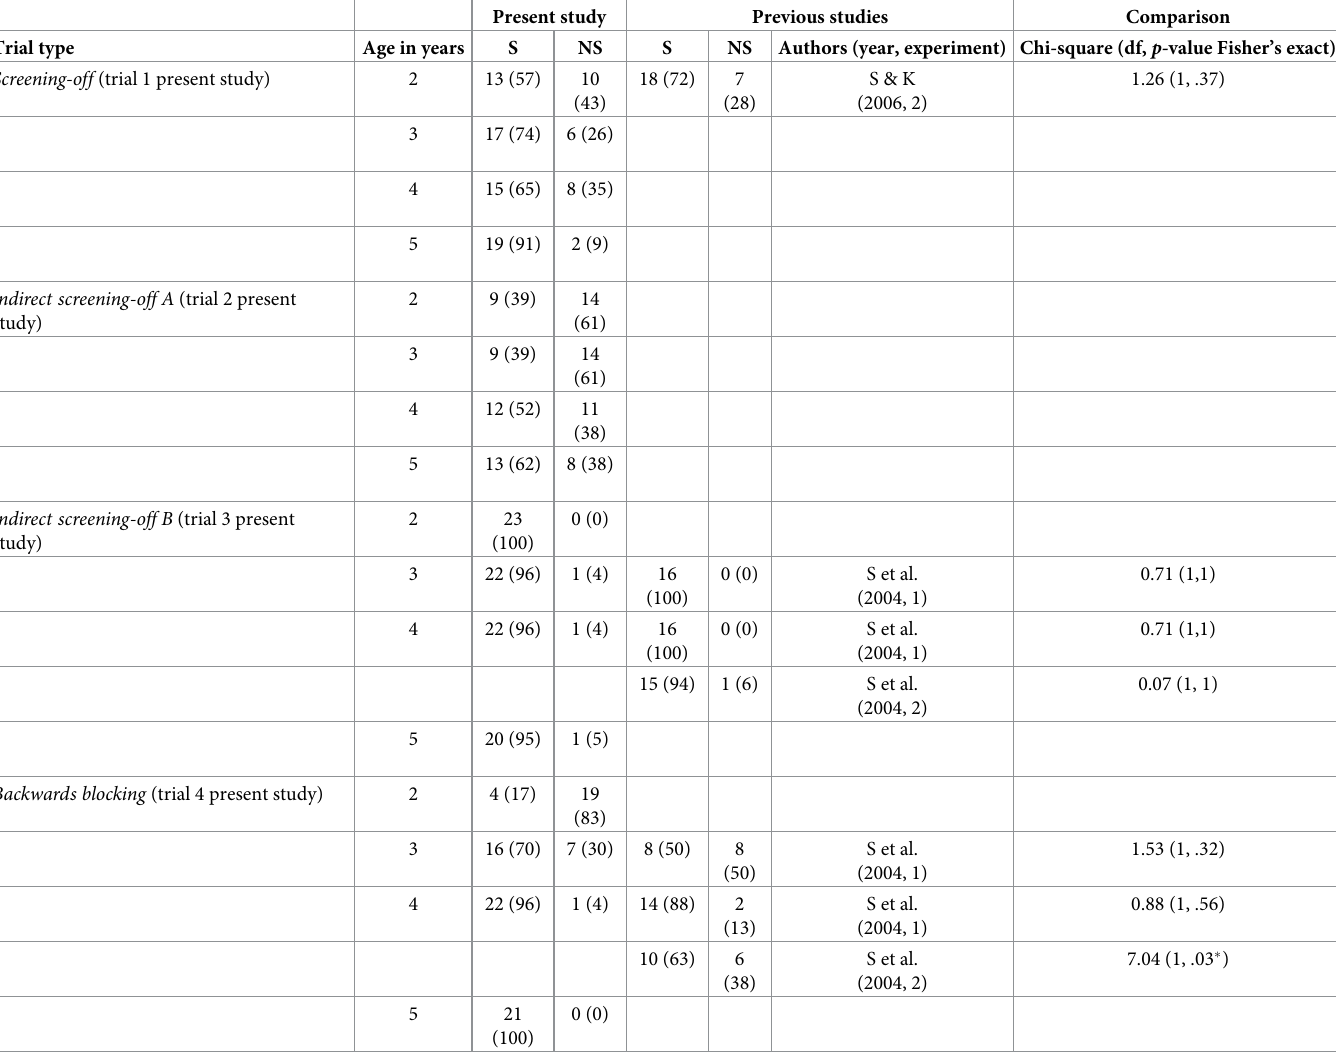
Table 1. Children’s responses on causal inference trials in the present study and comparison of these responses with previous studies; numbers (and percentages) of participants succeeding (S) and not succeeding (NS). Present study Previous studies